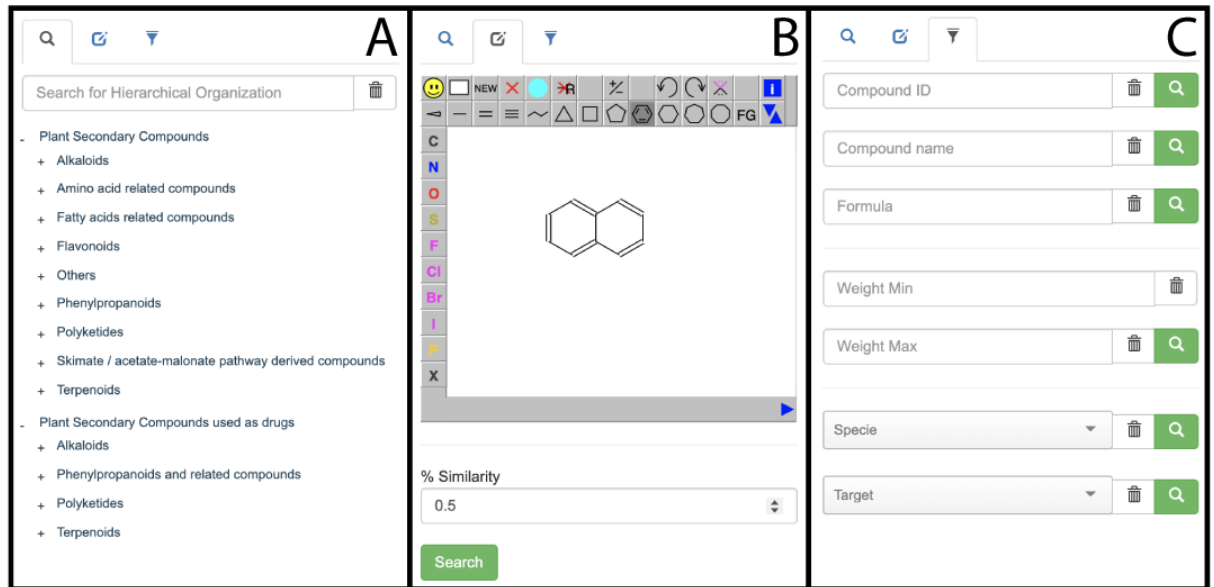
Figure 1. PSC-db search function. Users can search by the phytochemical compounds’ classification ( A ), by structural similarity ( B ), and by the following filters: compound ID, name, molecular formula, molecular weight range, source organism (species) and biological target ( C ).